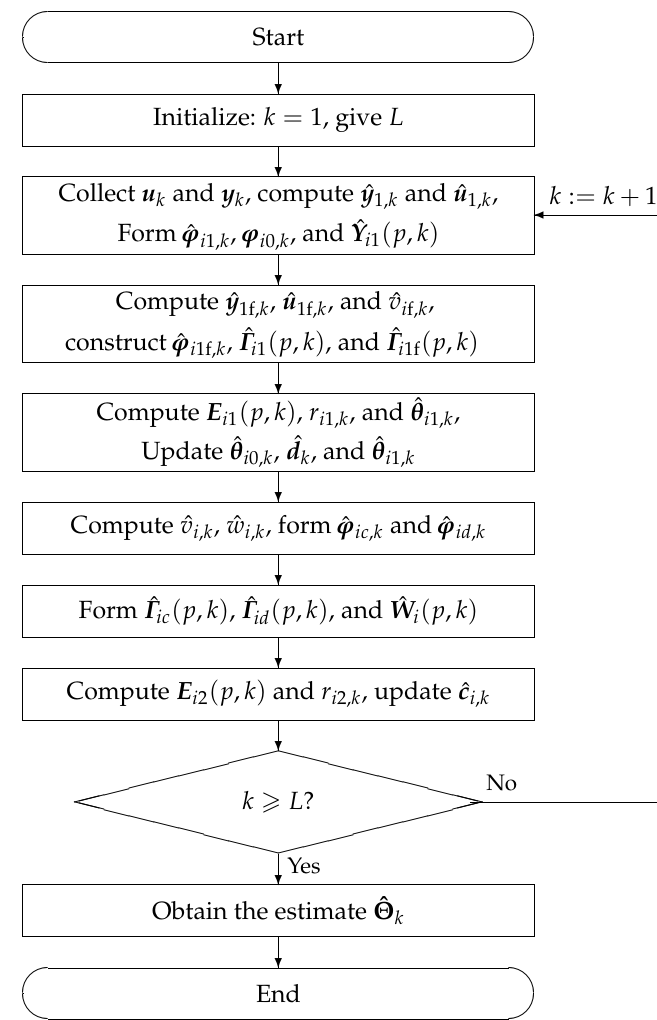
ˆ Θ i 1, k , ˆ c i , k and k